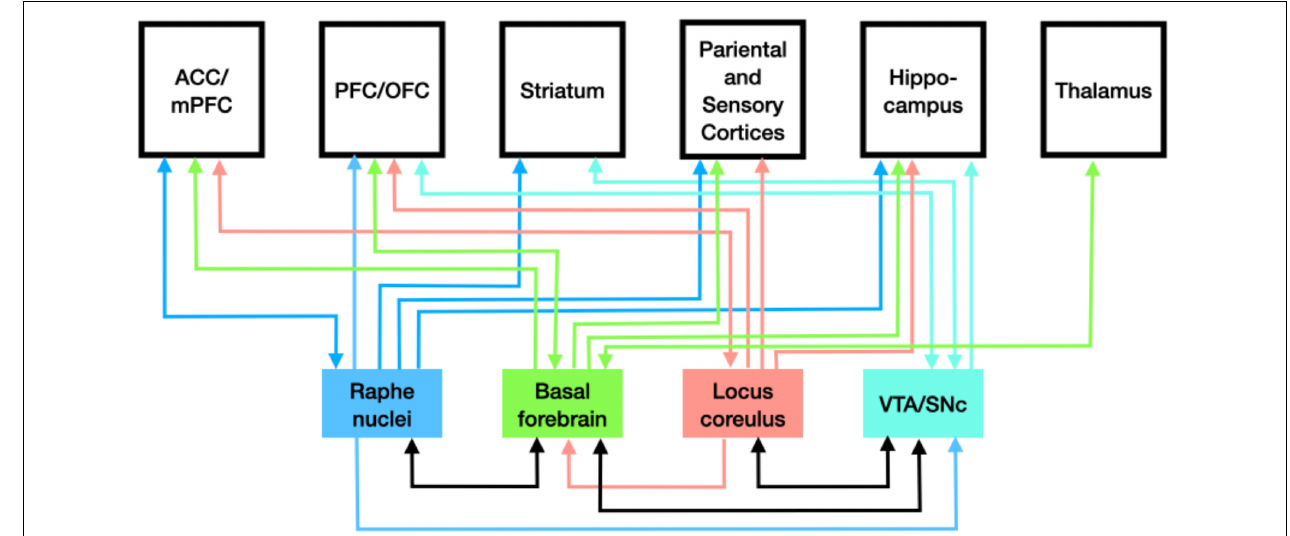
FIGURE 2 | Pattern of distribution of monoamines from the loci where each is